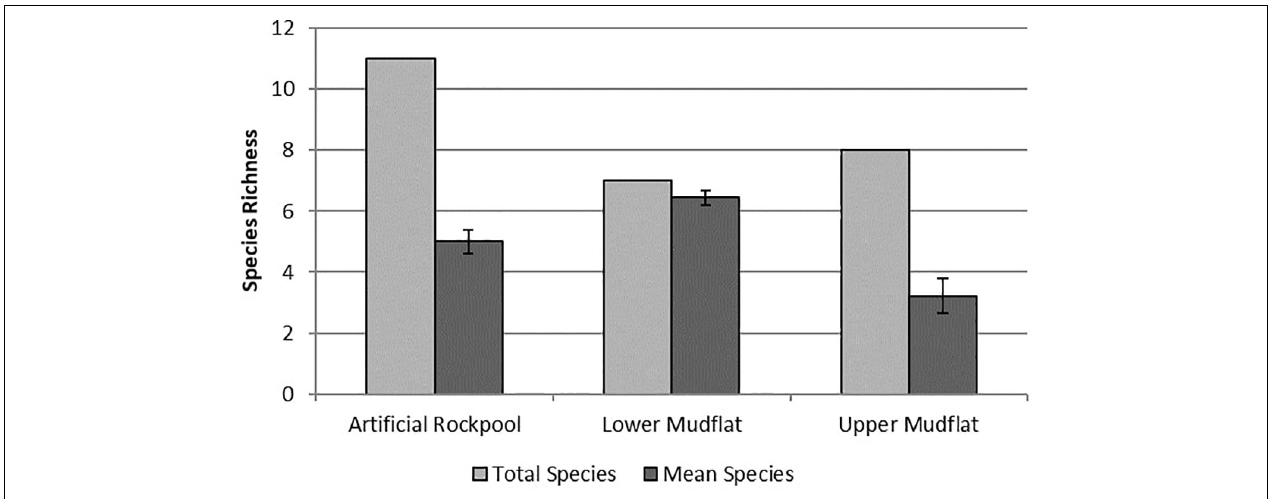
FIGURE 4 | Species richness for soft-bottomed habitats. “Total species” indicates the number of different taxa sampled in a habitat, whereas “mean species” is the average number of species per sample station/rockpool within that habitat ( n = 9). Error bars show ± Standard Error.